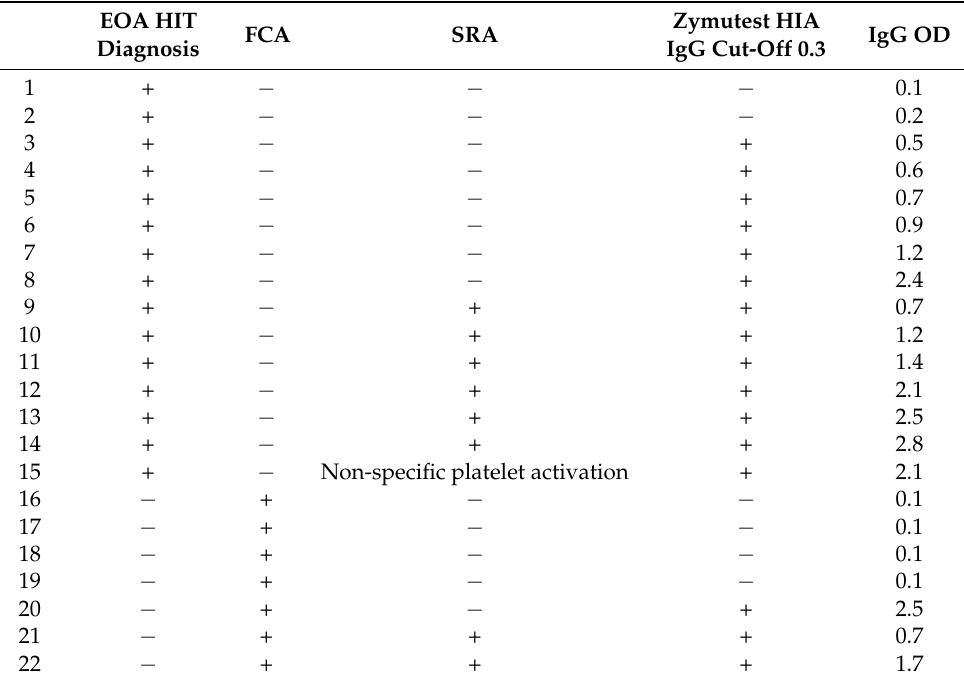
Table 1. False-negative and false-positive FCA results (based on EOA HIT diagnosis).